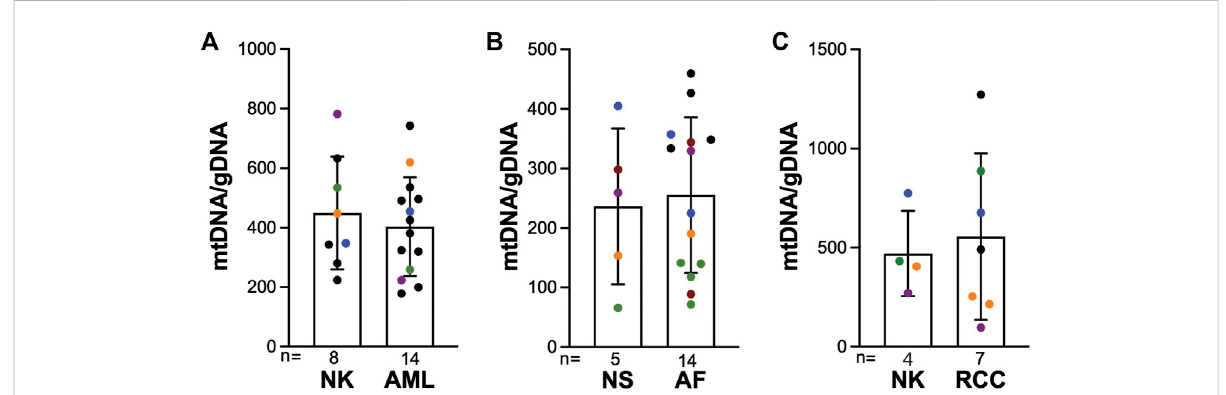
FIGURE 5 mtDNA/gDNA is unchanged in TSC tumors compared to corresponding normal tissue. (A – C) mtDNA/gDNA was measured in renal angiomyolipoma (AML), angio fi broma (AF), and renal cell carcinoma (RCC) compared to normal kidney (NK) or normal skin (NS). Black dots are unmatched samples, and all other colors indicate matched tumor-normal samples within each analyzed